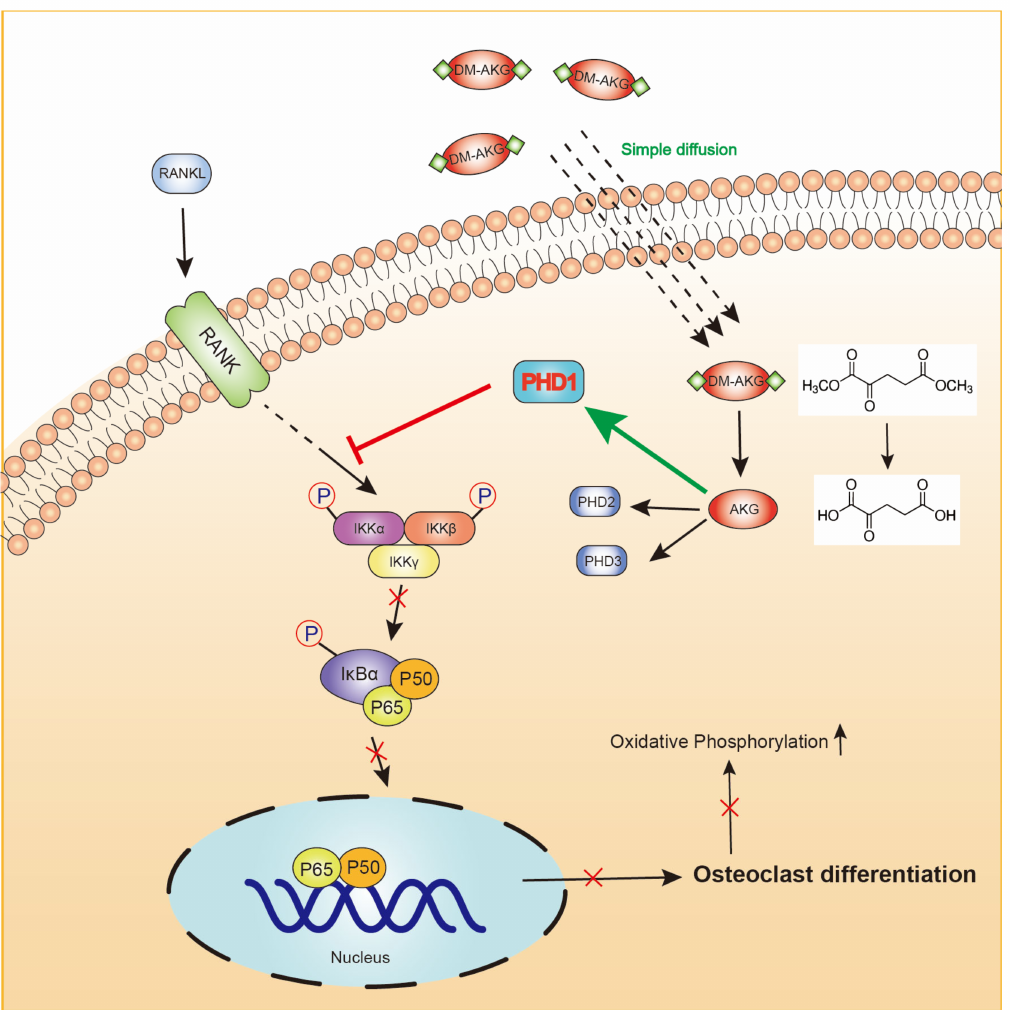
Figure 7. The proposed molecular mechanism underlying the elevation of intracellular AKG levels inhibits the RANKL-induced osteoclast